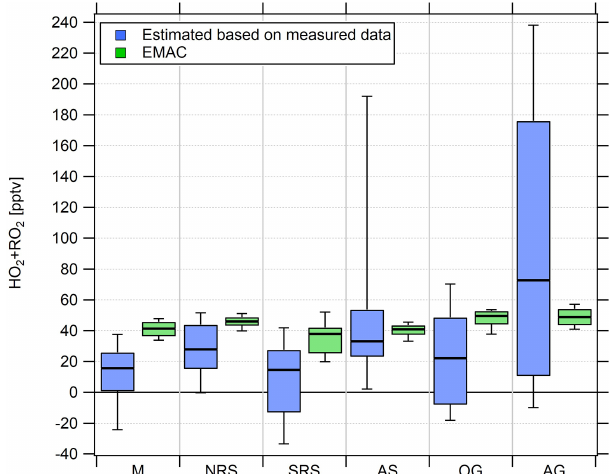
Figure 7. Comparison of box and whiskers plots of the regional estimated noontime ( HO 2 + RO 2 ) median based on measured data and simulated ( HO 2 + RO 2 ) data for the period from 18 July 2017